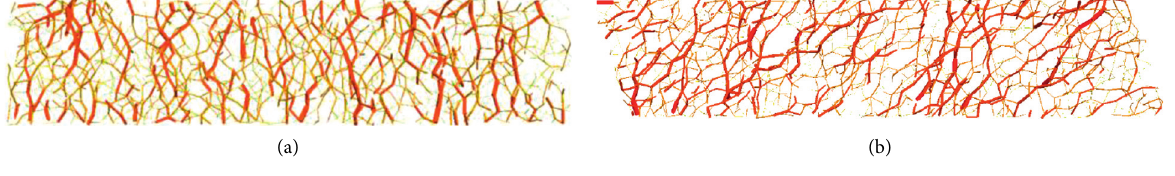
Figure 11: Contact force networks: (a) after consolidation; (b) at 20% shear